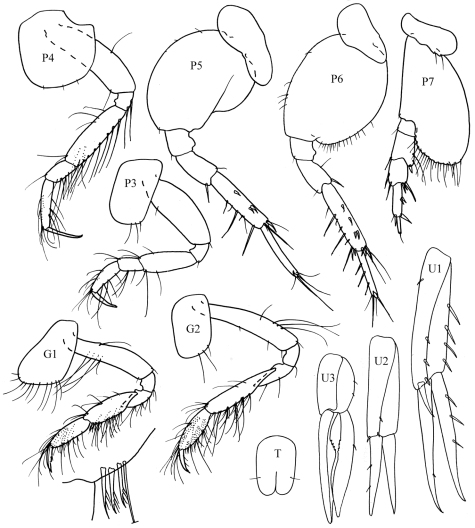

Byblis levissp. n., female.